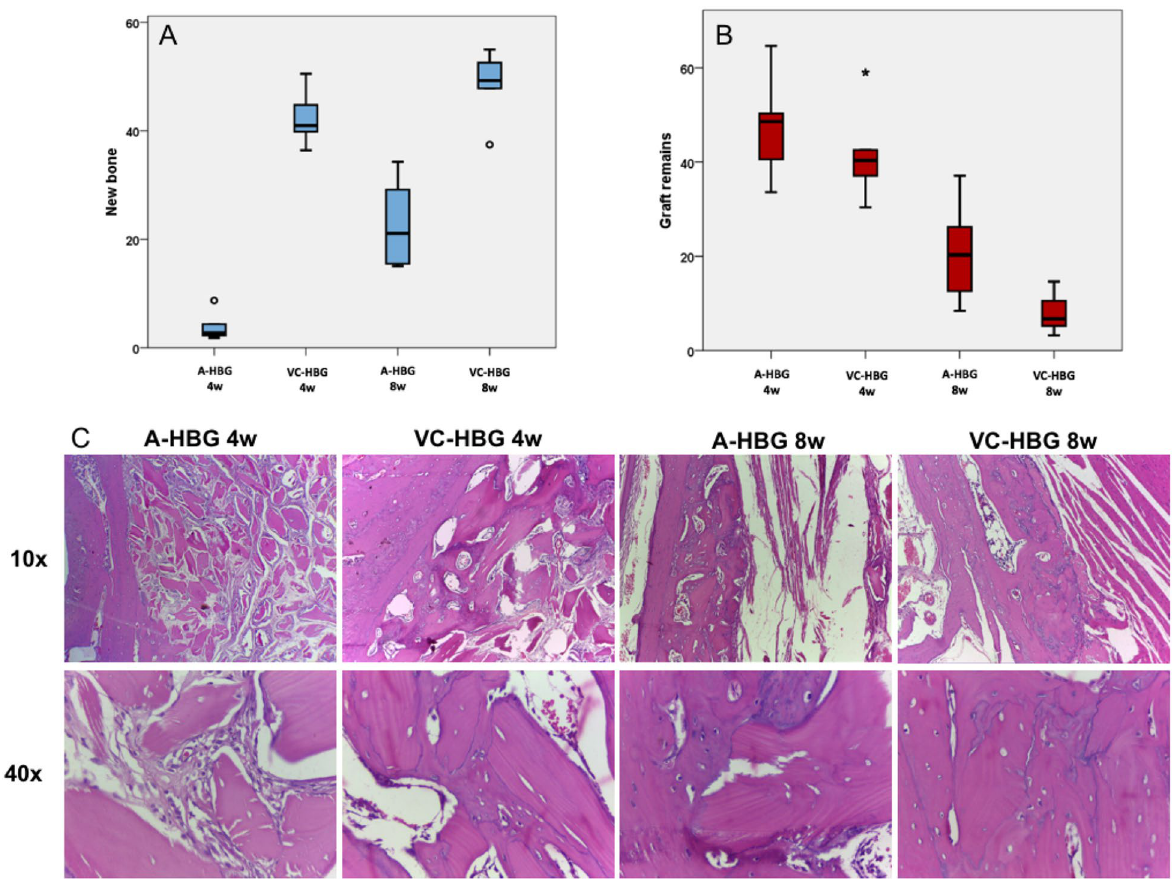
Figure 2. Association between new bone formation ( A ), graft remains ( B ) and graft type at each time point. Representative H&E pictures are depicted in ( C ) at 10× and 40× magnification. A-HBG acellular-human bone graft, VC-HBG viable cryopreserved-human bone graft.